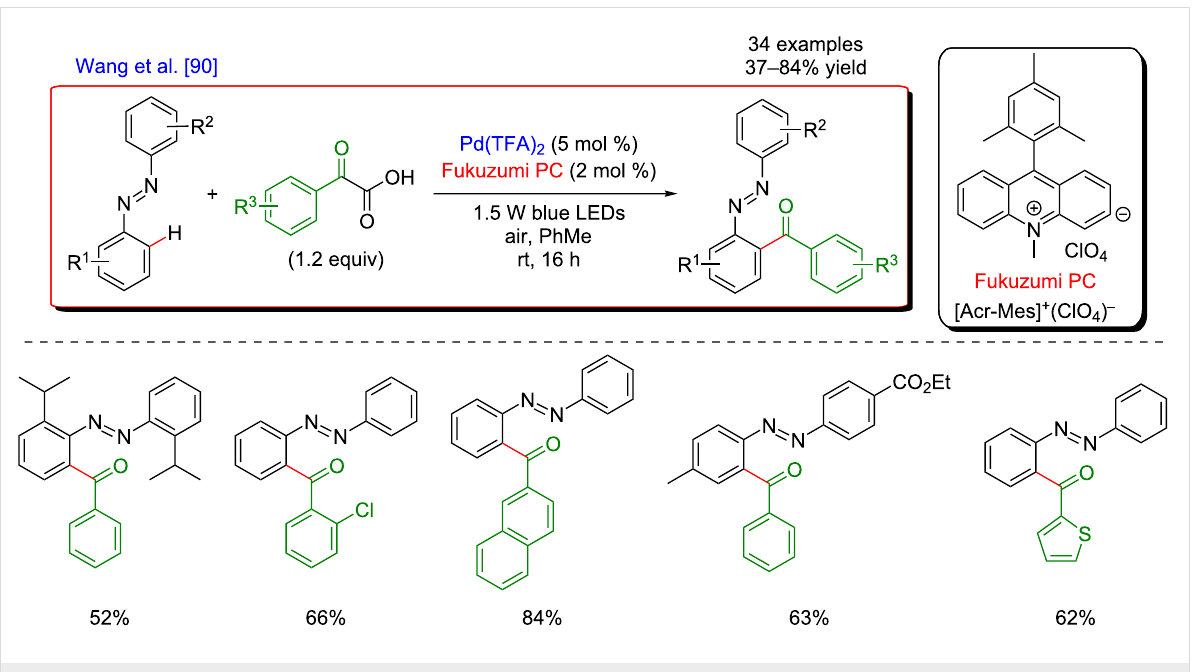
Figure 29: Acylation of azobenzenes via the dual catalysis C–H